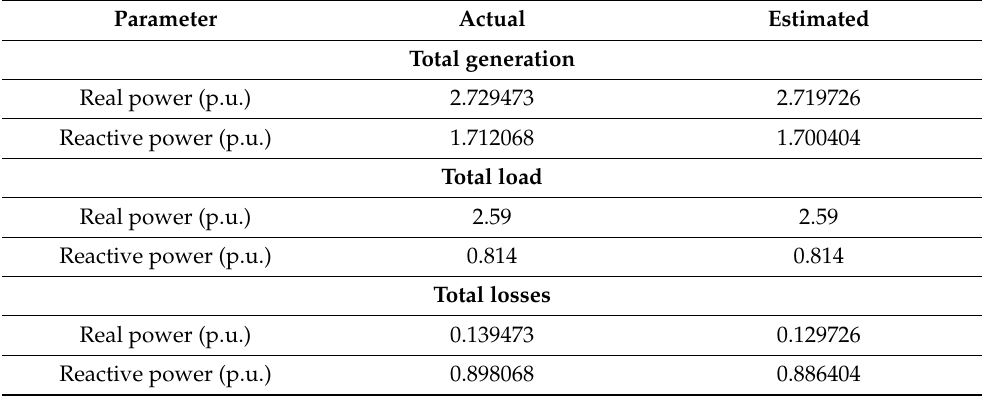
Figure 9. Active and reactive power flow of the IEEE 14-bus system from case study-3. Table 5. Power flow summary based on actual and estimated TLs parameters from case study-3. Parameter Actual